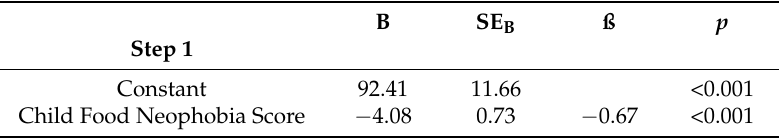
Table 6. Mean LED intake regression